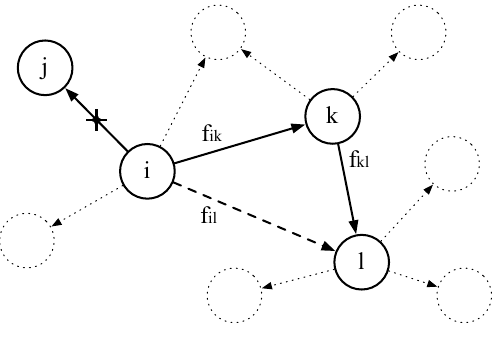
Figure 1. Illustration of the rewiring of link { ij } to { il } . Agent k is chosen to introduce player l to i (see text). Between any pair of connected agents there are two directed links: only one of them is shown for